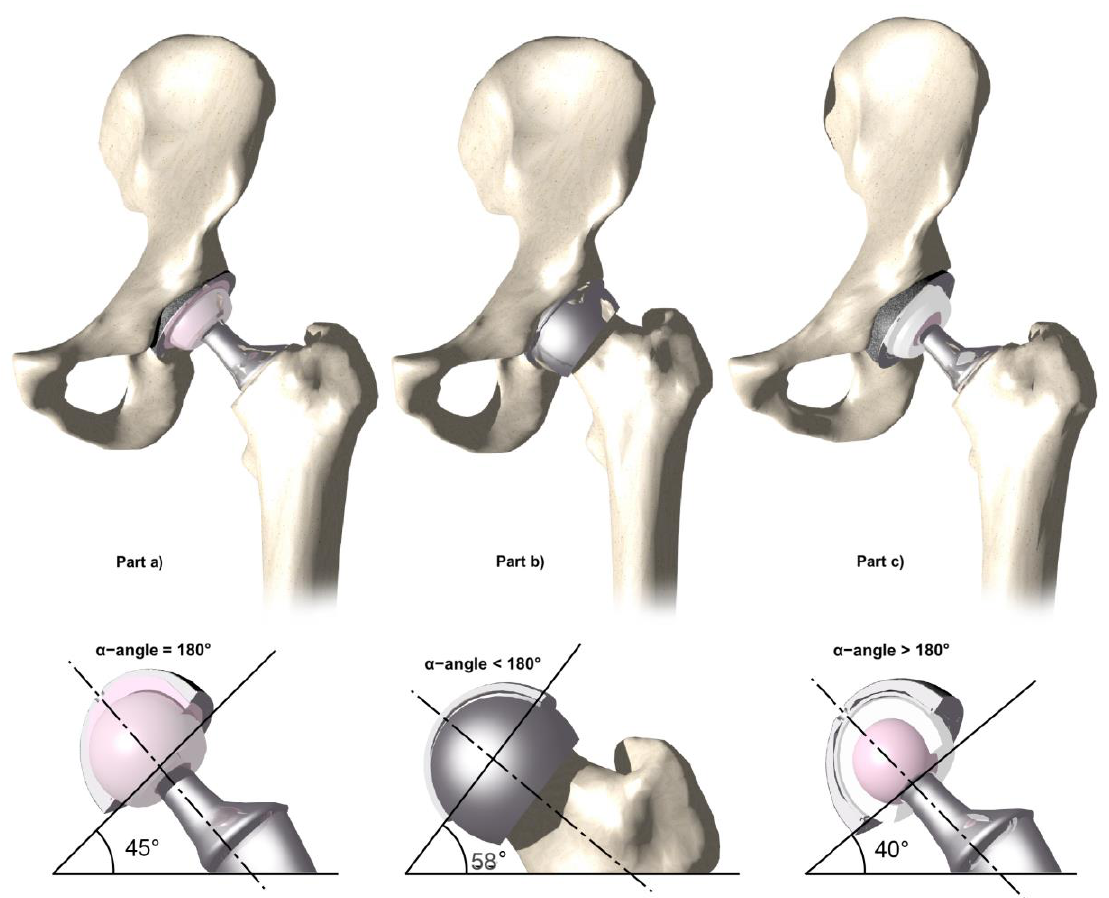
Figure 6. Effective inclination angles of various designs assuming an abduction angle of 45°. Part (a) Figure 6. E ff ective inclination angles of various designs assuming an abduction angle of 45 ◦ . shows a standard hip implant with an abduction angle of 45°(180° coverage angle); part (b) shows a Part ( a ) shows a standard hip implant with an abduction angle of 45 ◦ (180 ◦ coverage angle); part Birmingham Hip Resurfacing (BHR) resurfacing hip implant with an effective angle of inclination of ( b ) shows a Birmingham Hip Resurfacing (BHR) resurfacing hip implant with an e ff ective angle of 58° (less than 180° coverage angle); part (c) shows a DM hip implant with an angle of inclination of inclination of 58 ◦ (less than 180 ◦ coverage angle); part ( c ) shows a DM hip implant with an angle of 40° (more than 180° coverage angle). inclination of 40 ◦ (more than 180 ◦ coverage